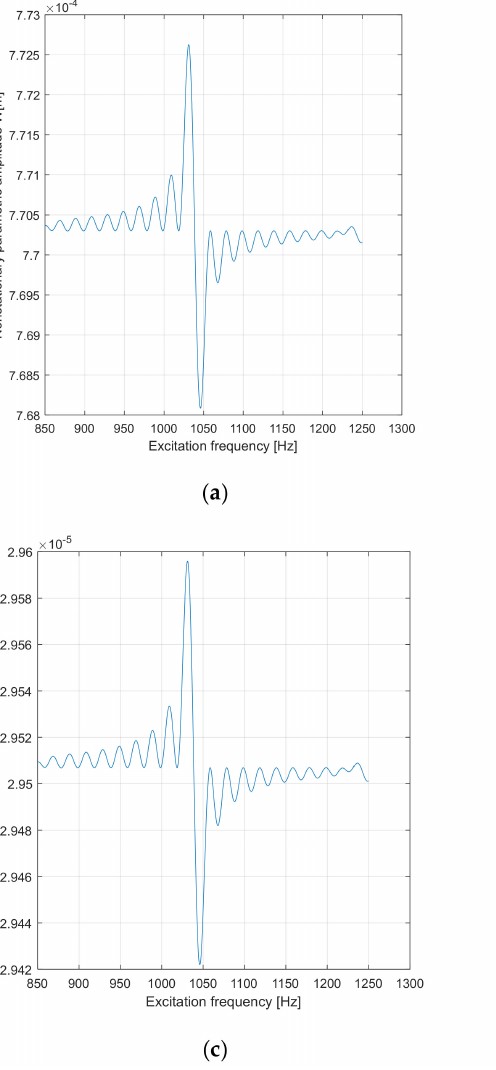
Figure 21. Nonstationary parametric amplitude spectrum W of the tulip for χ nT = 0.25, where µ = 0.623 × 10 − 4 . ( a ) ζ = 0.0016. ( b ) ζ = 0.0116. ( c ) ζ = 0.0216. ( d ) ζ = 0.0318. Here, m = 8 × 10 − 5